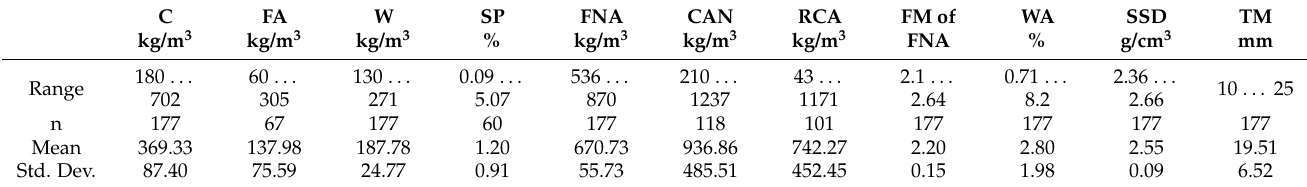
Table 2. Summarized values of the dataset